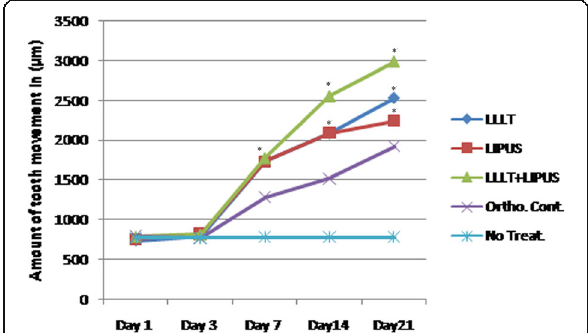
Fig. 5 Effect of LLLT, LIPUS, and combination of them on orthodontic tooth movement in rats at days 1, 3, 7, 14, and 21. At days 14 and 21, all the treatment groups were significantly higher than the control group. Among the treatment groups, the combination group was the highest, while the LIPUS group was the lowest; the data are shown as the mean ±SEM of three separate experiments. * P ≤ 0.05 between